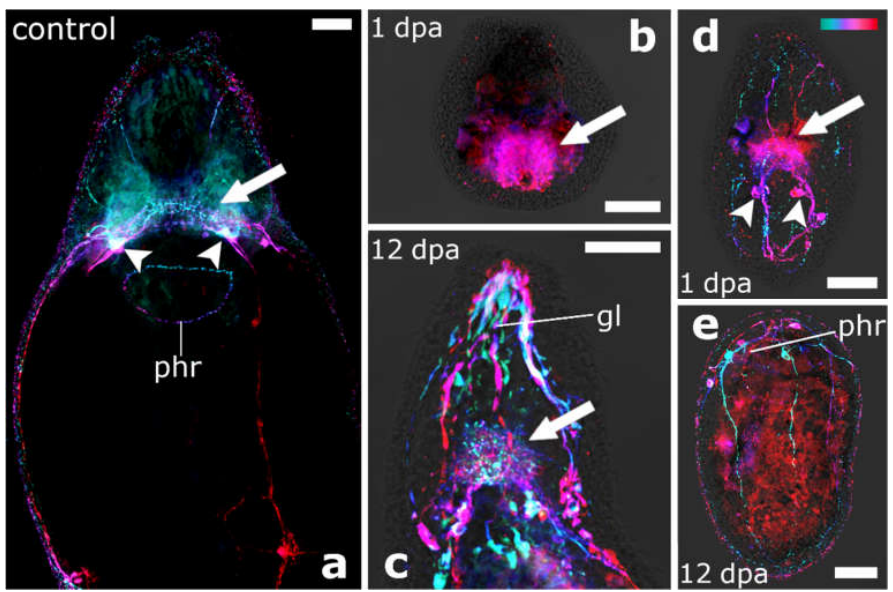
Figure 11. Staining of the serotonergic nervous system in anterior regenerates of Vorticeros auriculatum . ( a ) Intact animal (adapted from Figure 6b in Grosbusch et al. 2021). The presence of a brain in posterior ( b ) and anterior ( c ) regenerates of the same individual cut between brain and pharynx, fixed after 1 dpa and 12 dpa, respectively, indicates that the brain was regenerated in the anterior regenerate. Conversely, the presence of a brain in the posterior regenerate ( d ), but the absence of a brain in the anterior regenerate ( e ) of the same individual cut posterior of the pharynx, fixed after 1 dpa and 12 dpa, respectively, indicates that brain and pharynx were not regenerated in the anterior regenerate. Anterior is up in all images. All images are depth-coded and ( b - e ) are overlaying a brightfield image. Turquoise is more dorsal, red more ventral in ( b - c ), turquoise is more ventral, red more dorsal in ( d - e ). Arrowheads point to the brain roots while full arrows point to the neuropil. Abbreviations: gl, glands; phr, pharyngeal nerve ring. Scale bars are 50 µm.